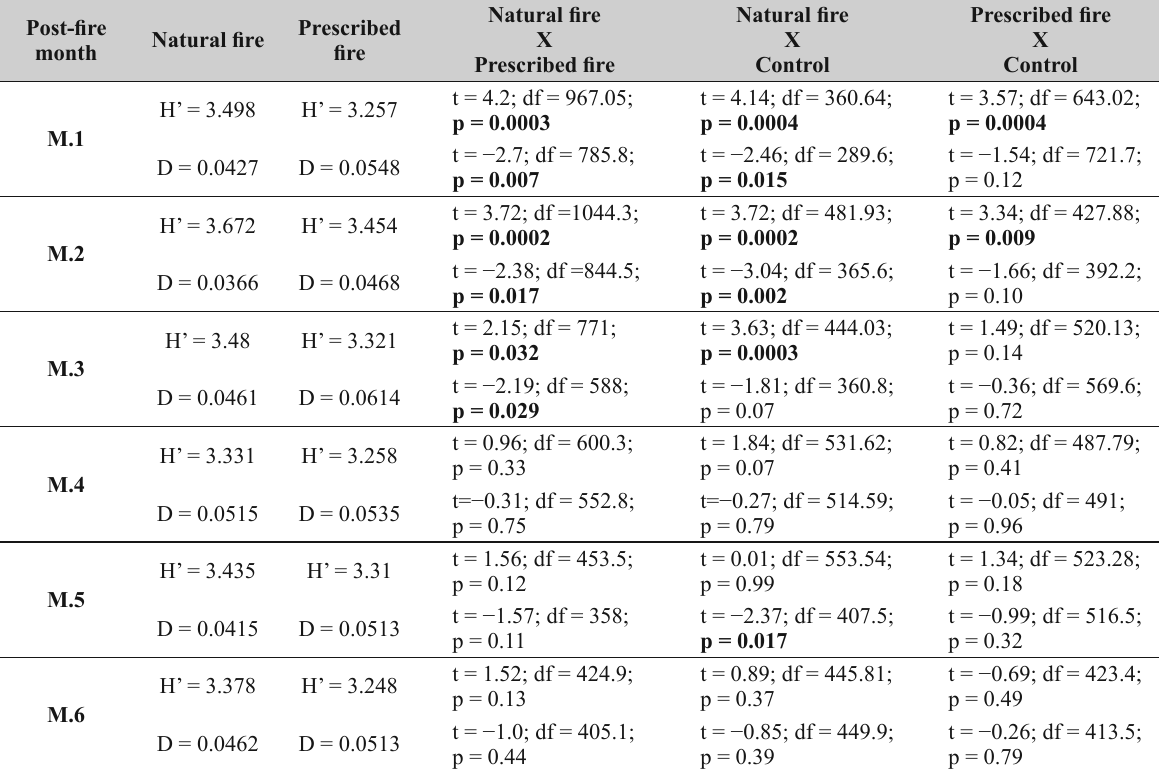
Diversity t-test results. M.1 to M.6 = sampled months after the fi re. H’ = diversity index. D = dominance. Statistically signi fi cant results are